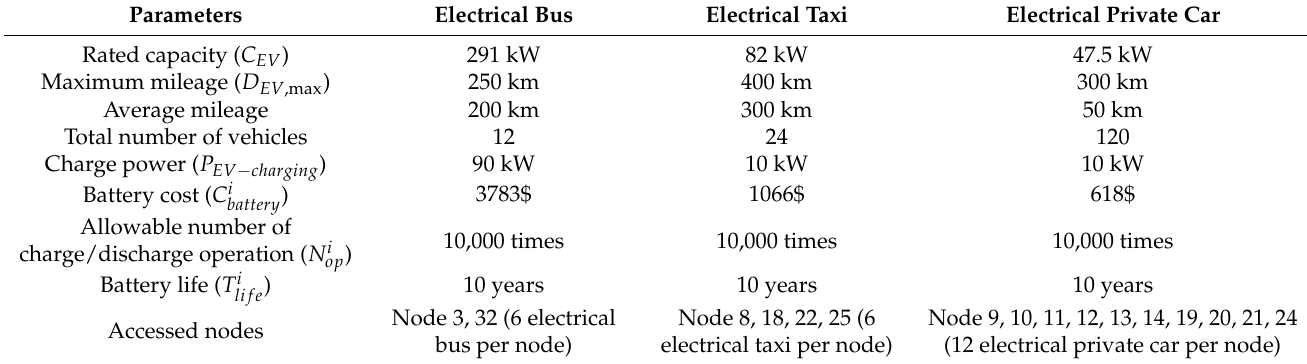
Table A2. Parameters of EV.